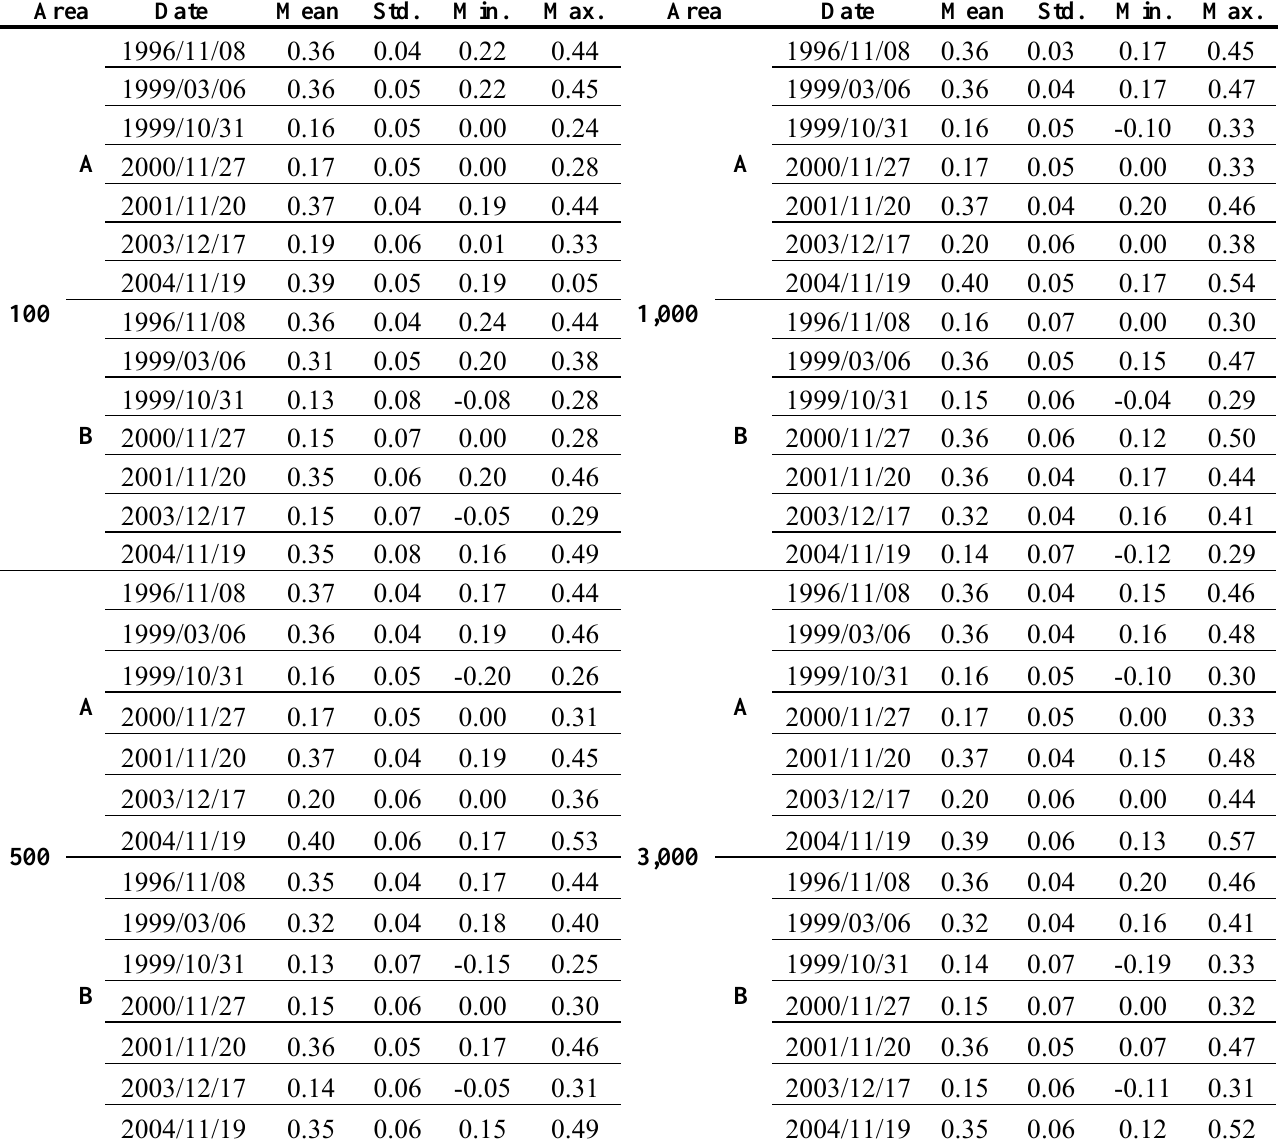
Table 3. Statistics of 100, 500, 1,000 and 3,000 samples from NDVI images.